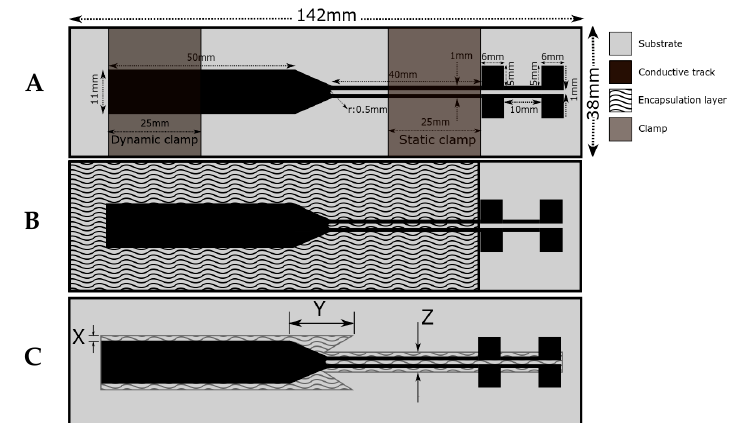
Figure 3. A schematic of stretchable interconnects. The dimensions of the substrate, conductive track and clamps are the same for all cases. ( A ) a non-encapsulated sample (Set 1). ( B ) An entirely encapsulated sample (Set 3 and Set 5) (except for the pads used for electrical characterization) corresponding to Figure 2B,D. ( C ) A partially encapsulated sample (Set 2 and Set 4) (X, Y, and Z are offsets) corresponding to Figure 2A,C.